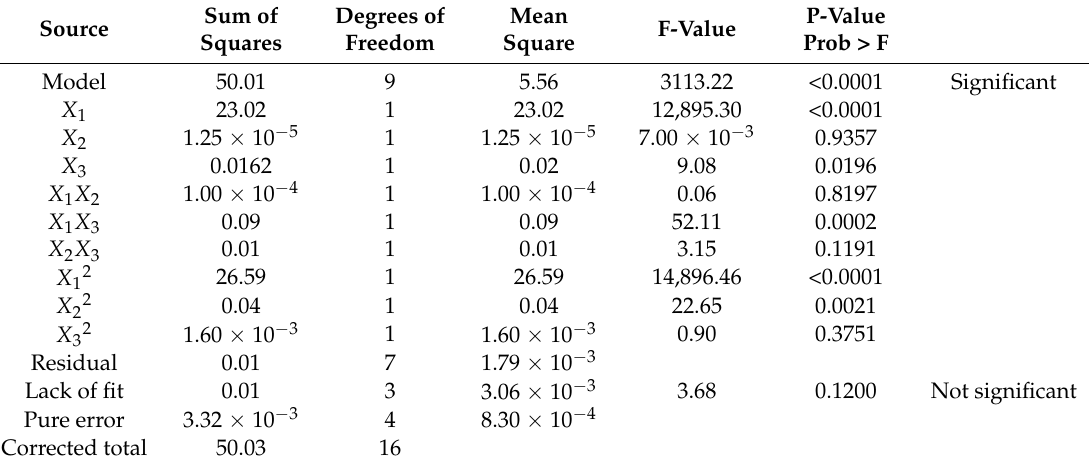
Table 4. Analysis of variance (ANOVA) of relative density for selected experimental correlation using